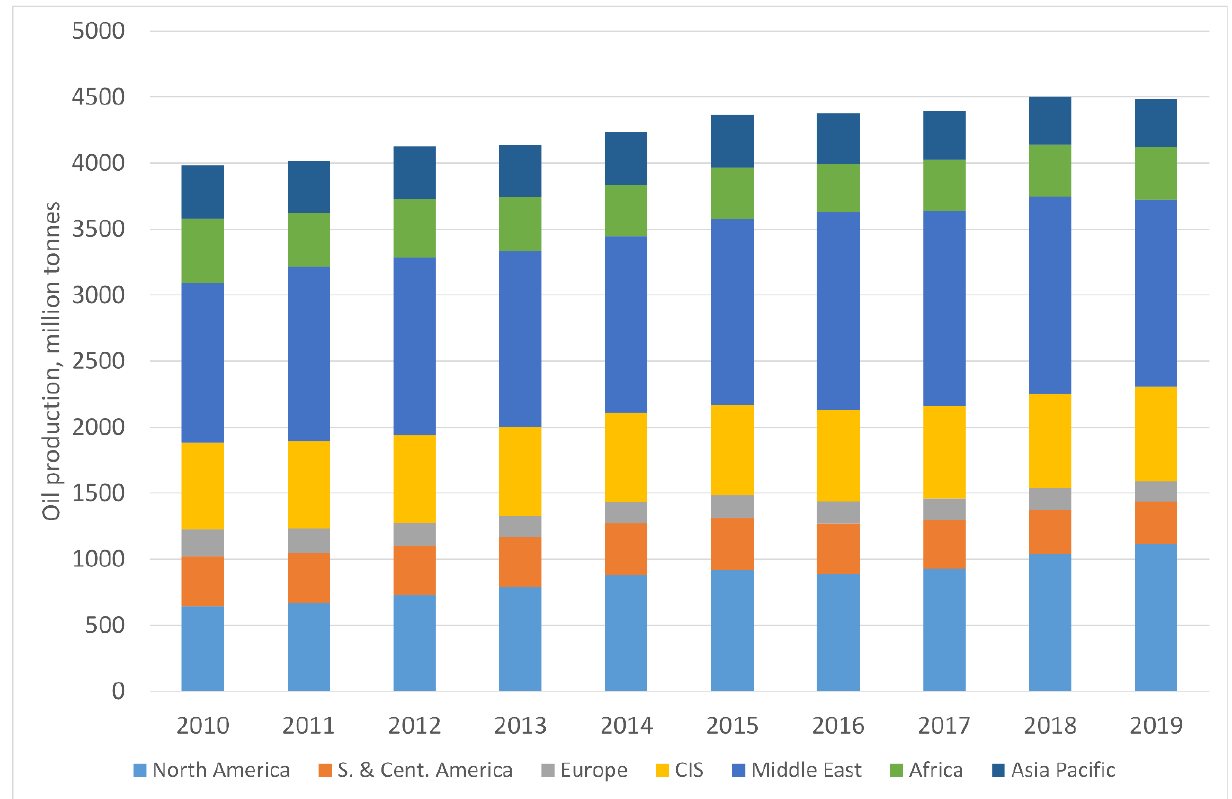
Figure 1. Volumes of crude oil production from 2010 to 2019 by country.